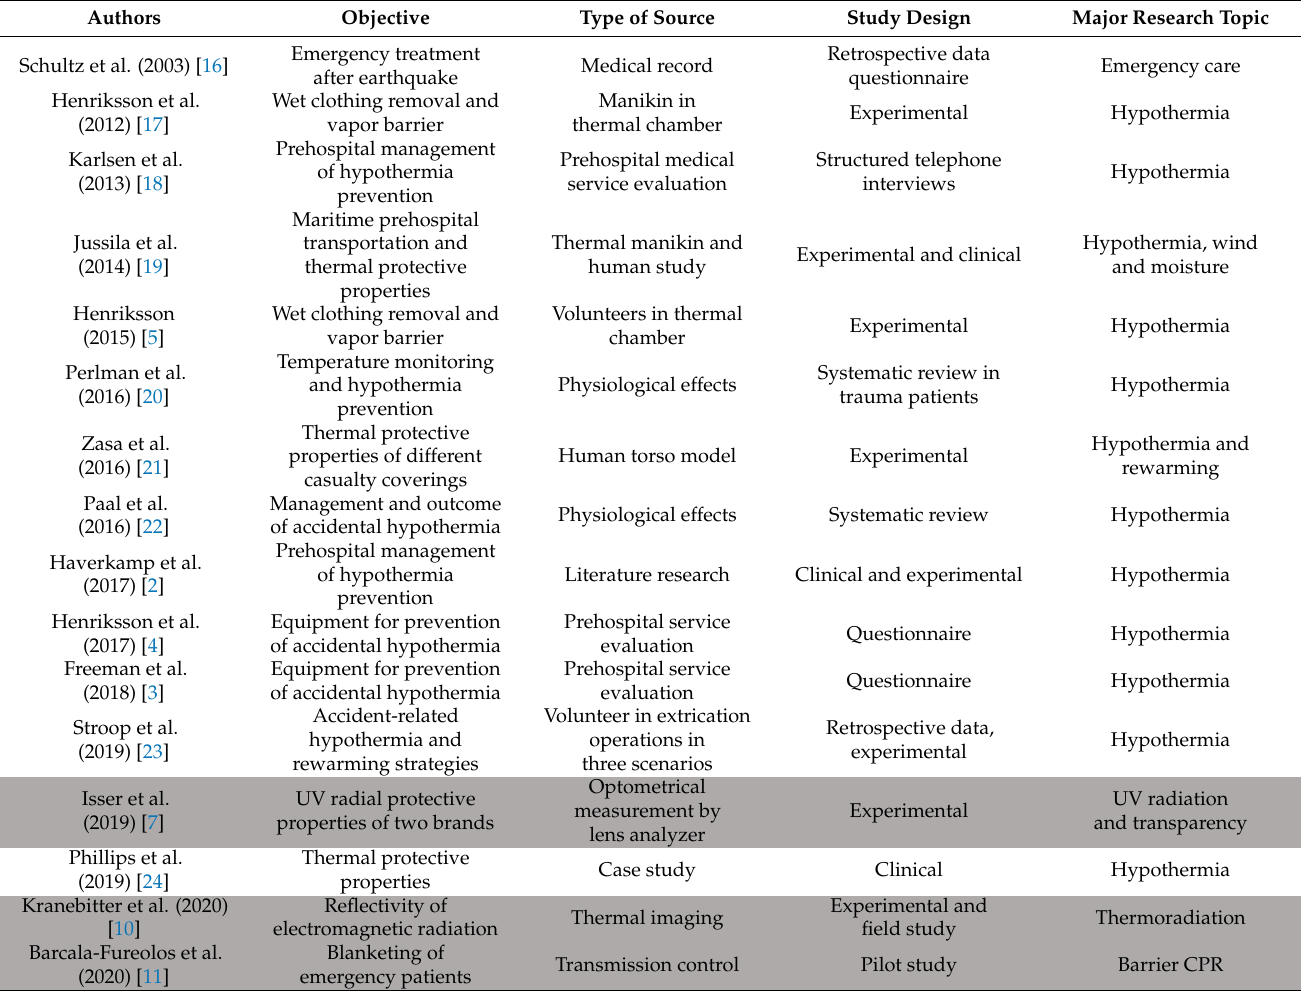
Table 1: List of the 26 articles included in the quantitative analysis of the narrative review. The grey lines represent those nine studies that indicate alternative applications of rescue blankets and were thus included in the qualitative analysis. Table 1. Findings of the reviewed sources after screening on PubMed ® and Web of Science TM